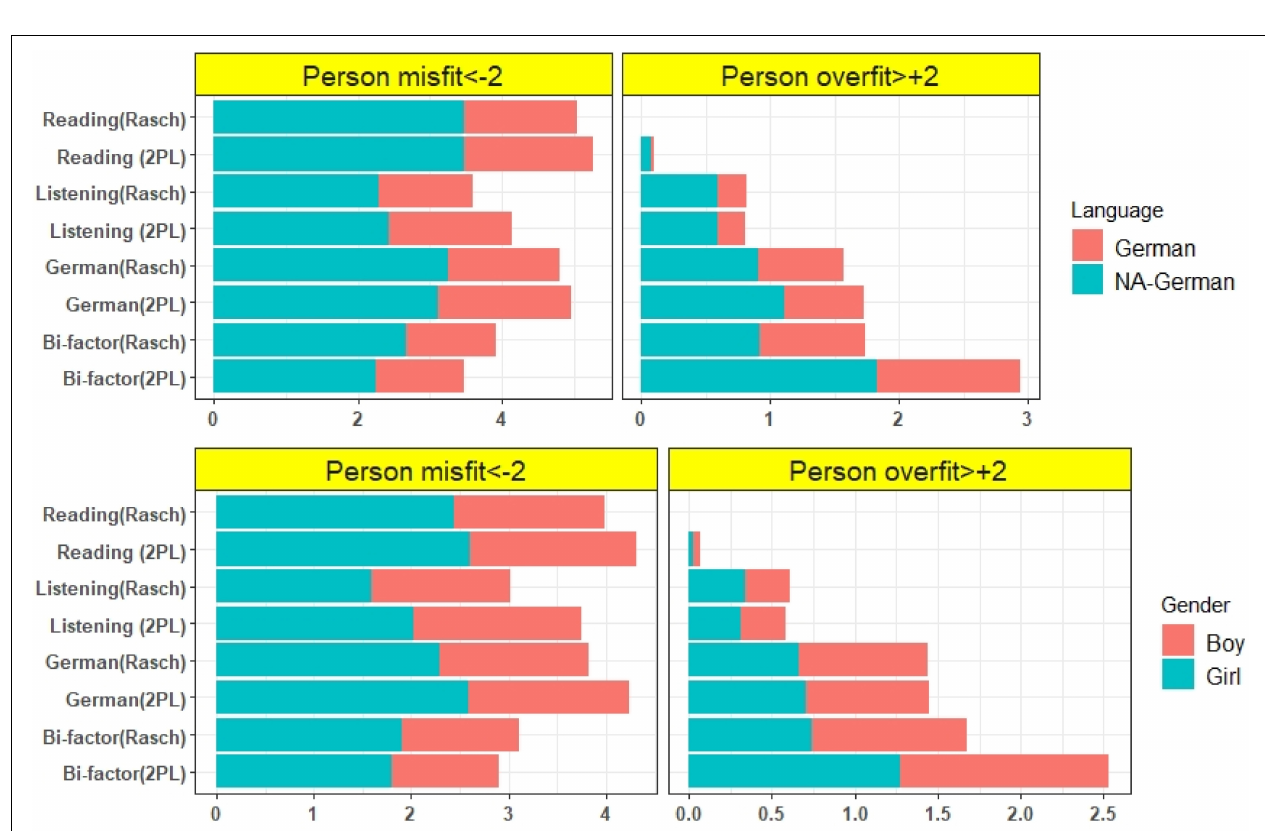
FIGURE 6 | Proportion (%) of the misfit and overfit person of unidimensional reading, listening, German test and bifactor model of German test.